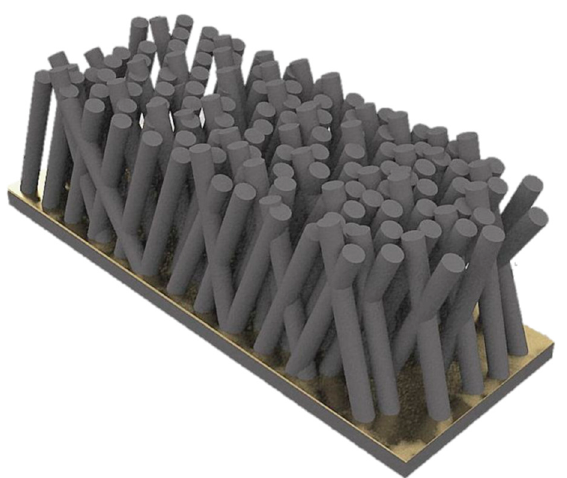
Figure 1. Scanning electron microscope (SEM) images of the polycarbonate (PC) membrane ( a , c ) and nanostructures ( b , d ): ( a , b ) cross-sectional view and ( c , d ) top view.